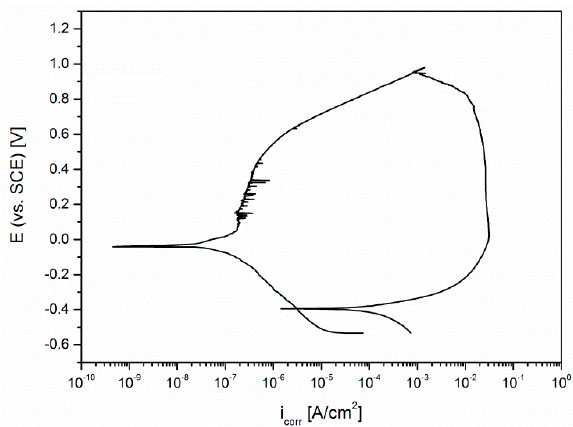
Figure 16. Measurement of pitting corrosion resistance for a coating formed at nitrogen pressure of 5 Pa on a steel HS6-5-2 substrate.